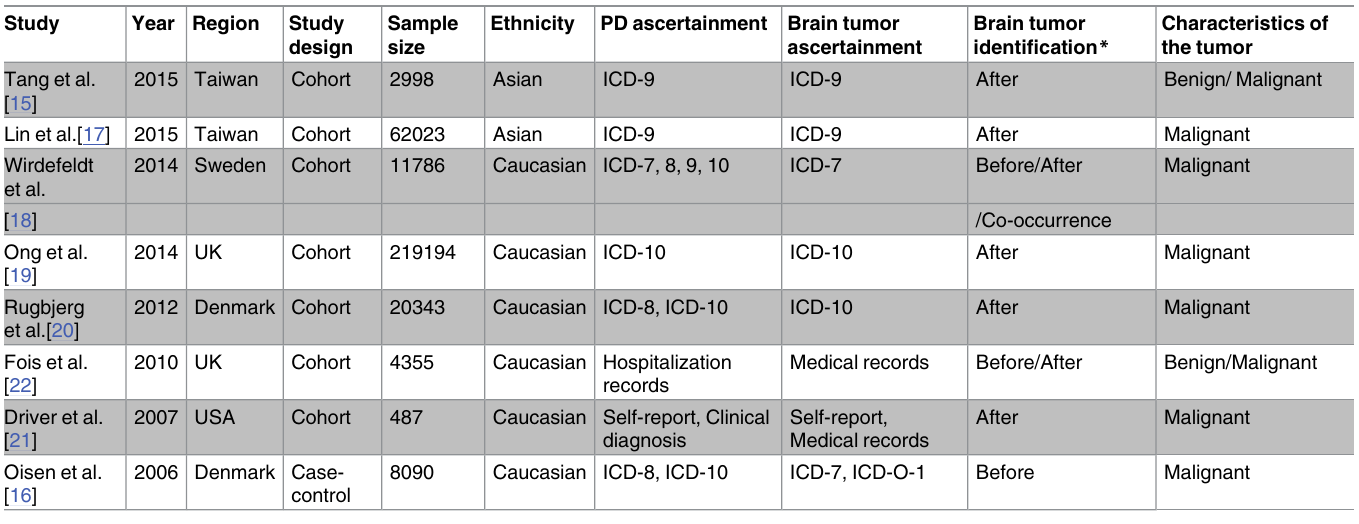
Table 1. Characteristics of Individual Study in the Meta-analysis.